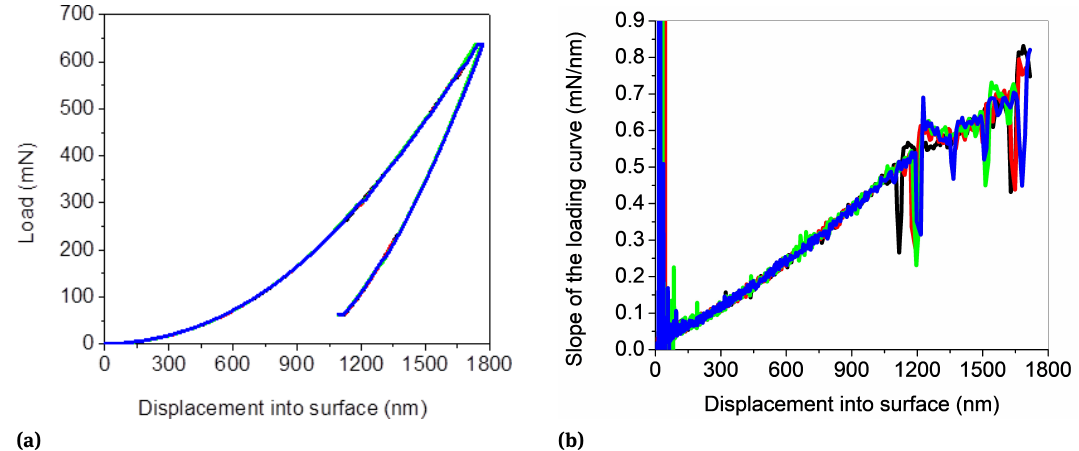
Figure 18: p-h and Slope of the loading curve Vs. displacement for the film 93:7 Ar:N 2